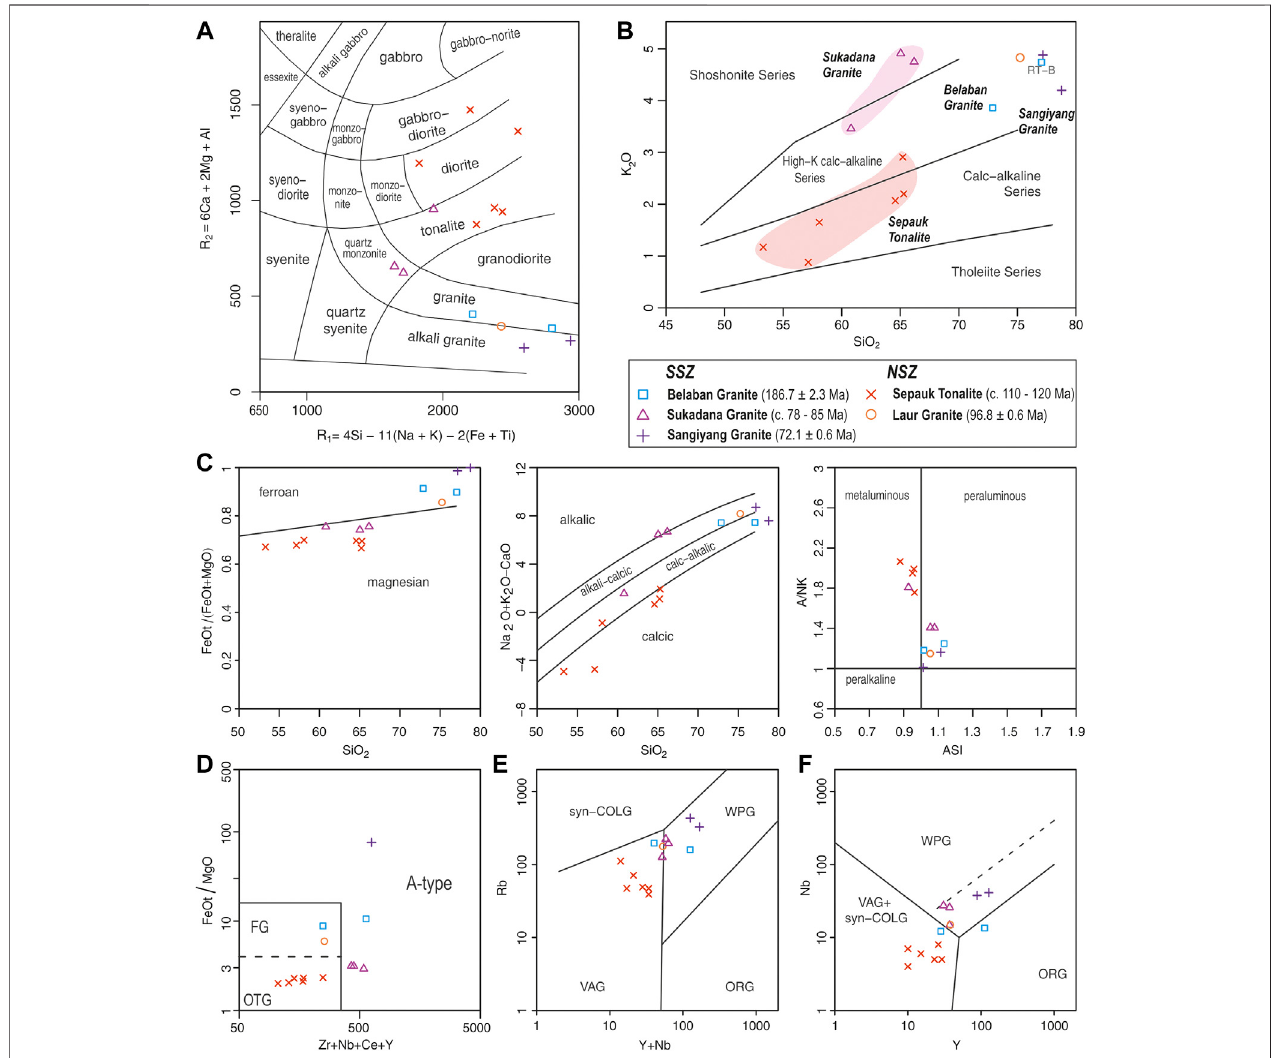
FIGURE 9 | Geochemistry classi fi cation diagrams of intrusive rocks of the Schwaner Mountains. (A) R1-R2 classi fi cation diagram (after De La Roche et al., 1980). (B) K 2 O-SiO 2 classi fi cation (after Peccerillo and Taylor, 1976). (C) Granite classi fi cation diagrams (Frost et al., 2001). (D) A-type granite classi fi cation (after Whalen et al., 1987). (E, F) Tectonic setting of granitoids of the Schwaner Mountains (after Pearce et al., 1984).